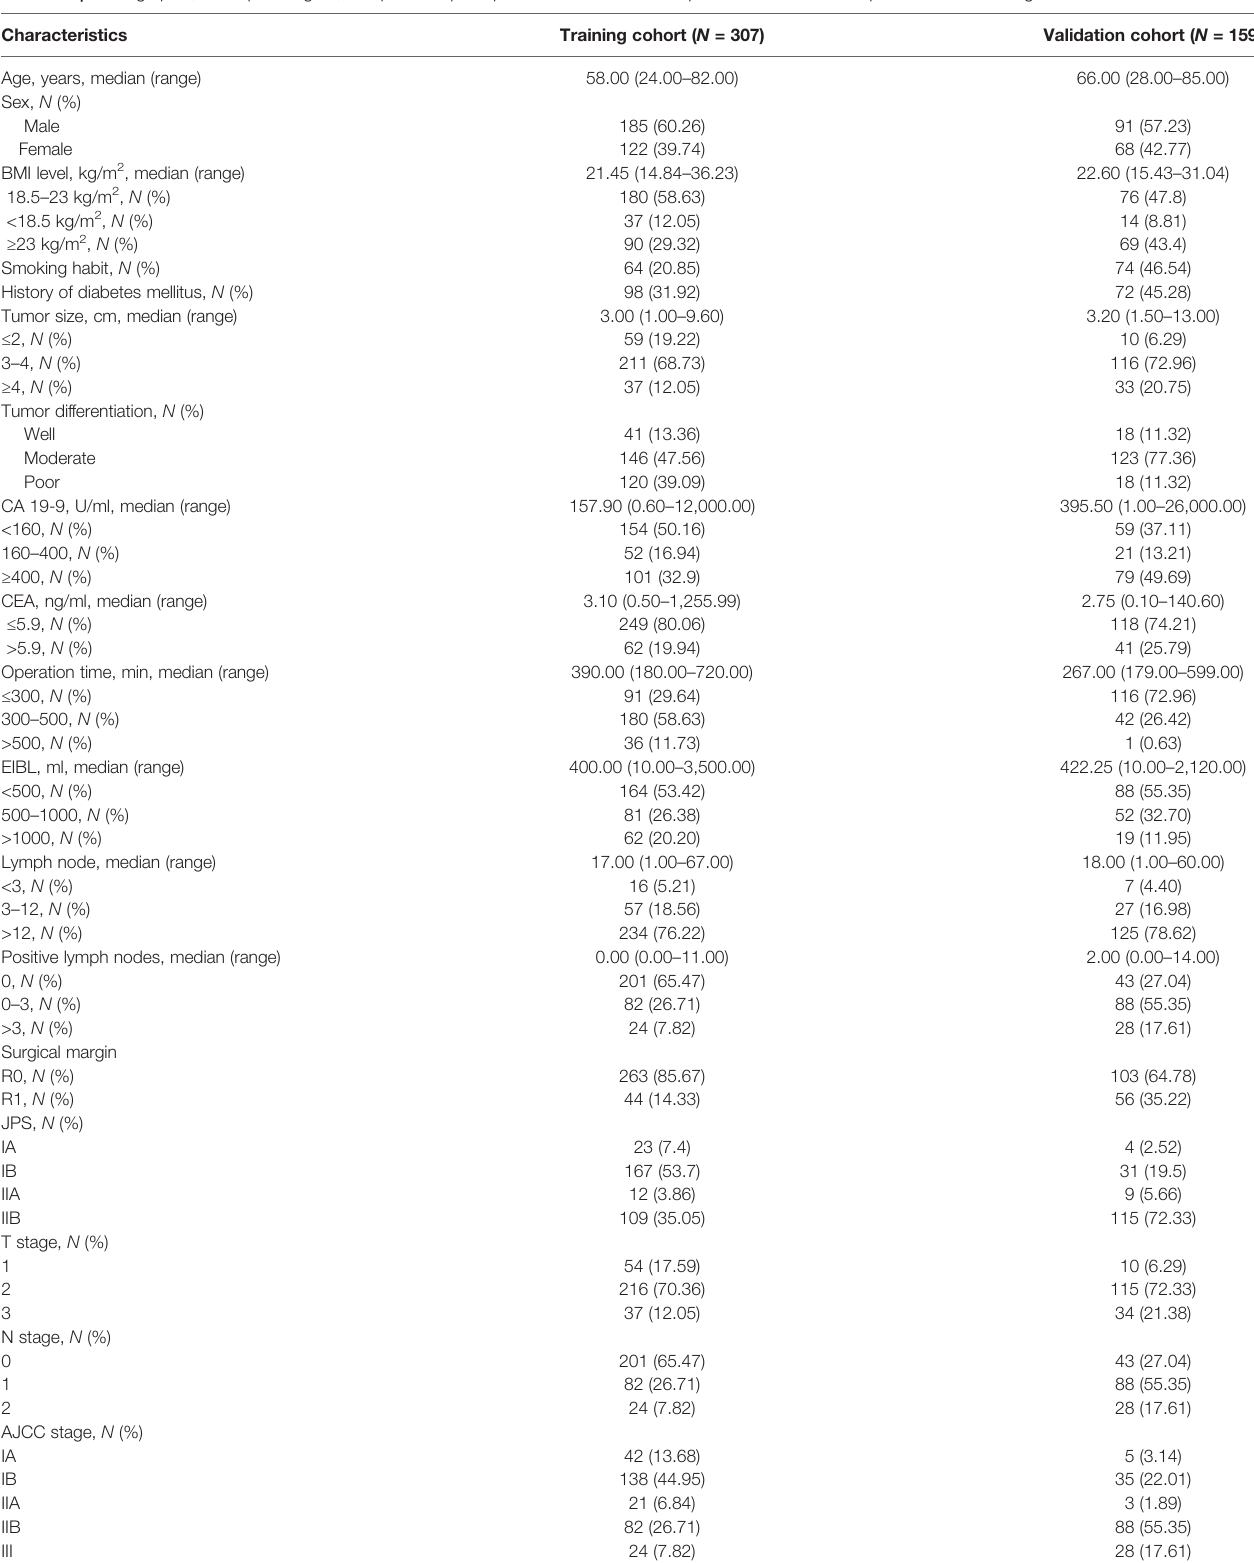
TABLE 1 | Demographic, clinicopathological, and pre- and postoperative characteristics of pancreatic head cancer patients in the training and validation cohorts.